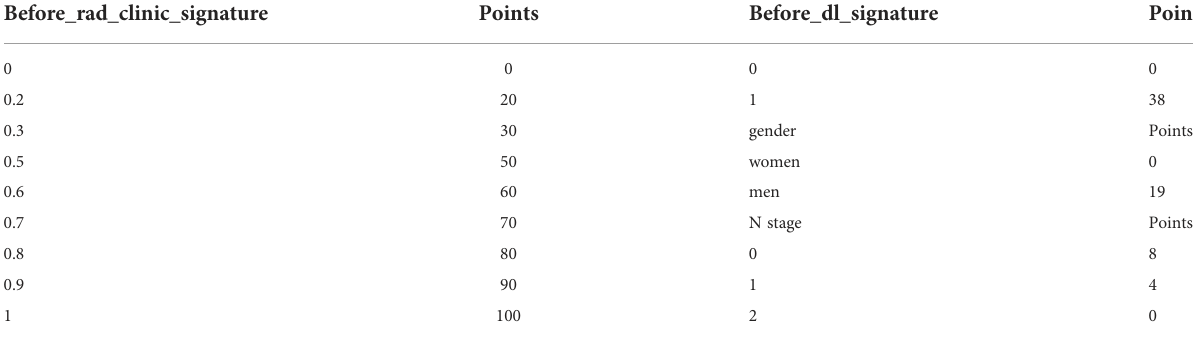
TABLE 17 The features in the nomogram and the corresponding scores.